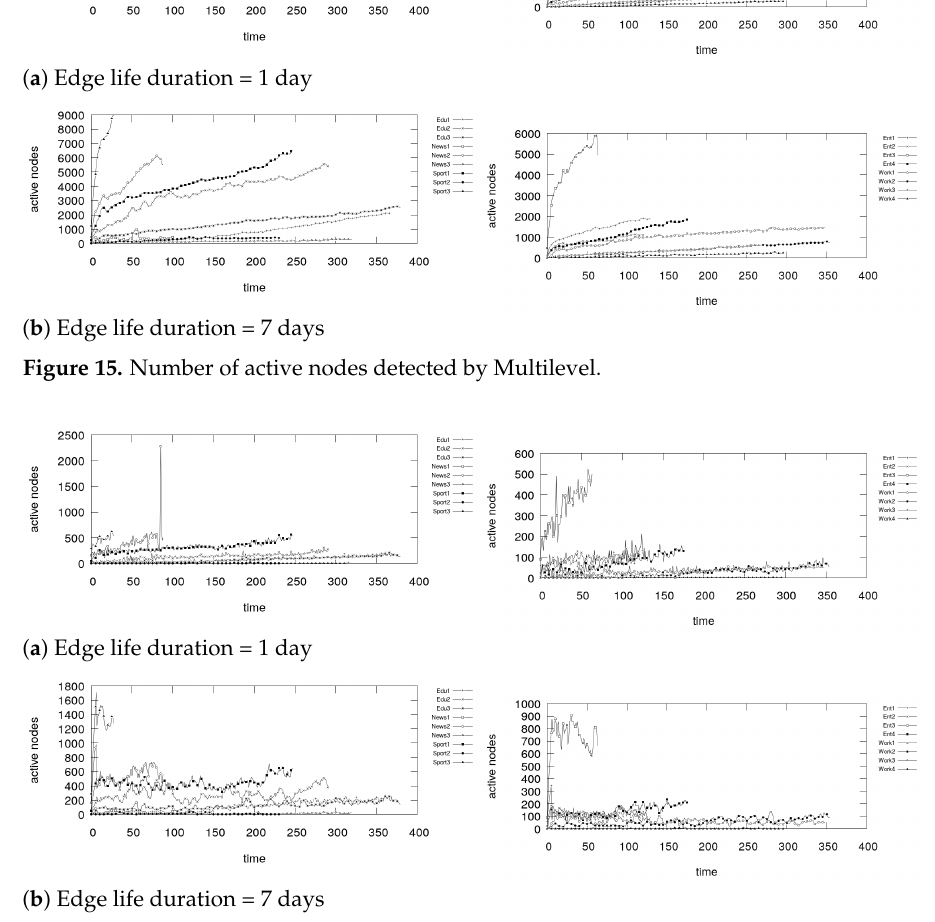
Figure 16. Number of active nodes detected by